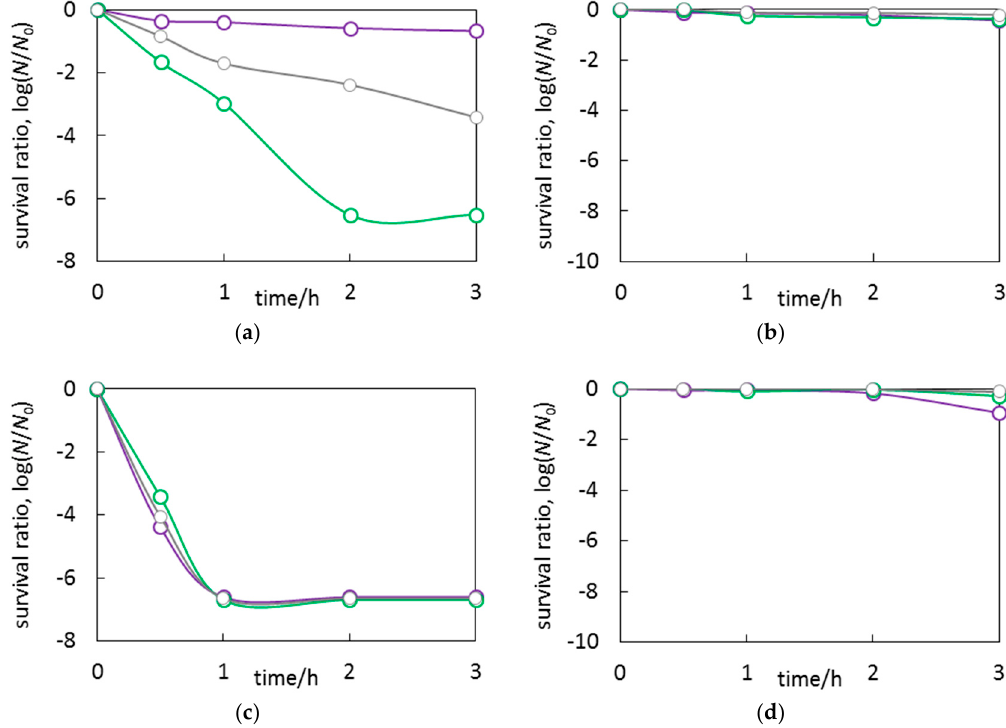
Figure 13. Survival ratio of C. albicans in the presence of 5 wt% Ag 2 O/ST01 ( a ), 1 wt% Ag 2 O/ST01 ( b ), Ag 2 O ( c ) and bare ST01 ( d ) under UV irradiation (purple, 300 < λ < 420 nm), vis irradiation (green, λ > 420 nm), and in the dark (grey).